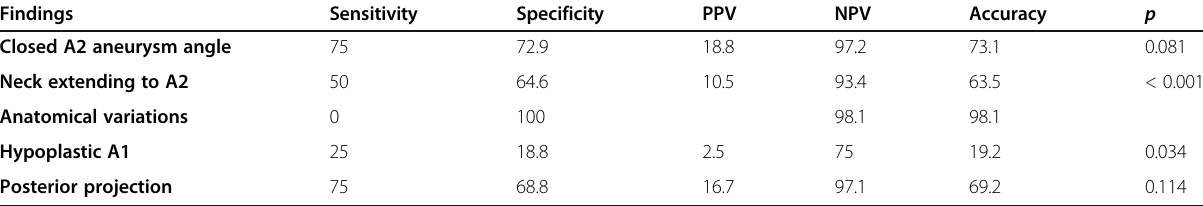
Table 4 Performance of CTA findings in prediction of mortality among the studied patients